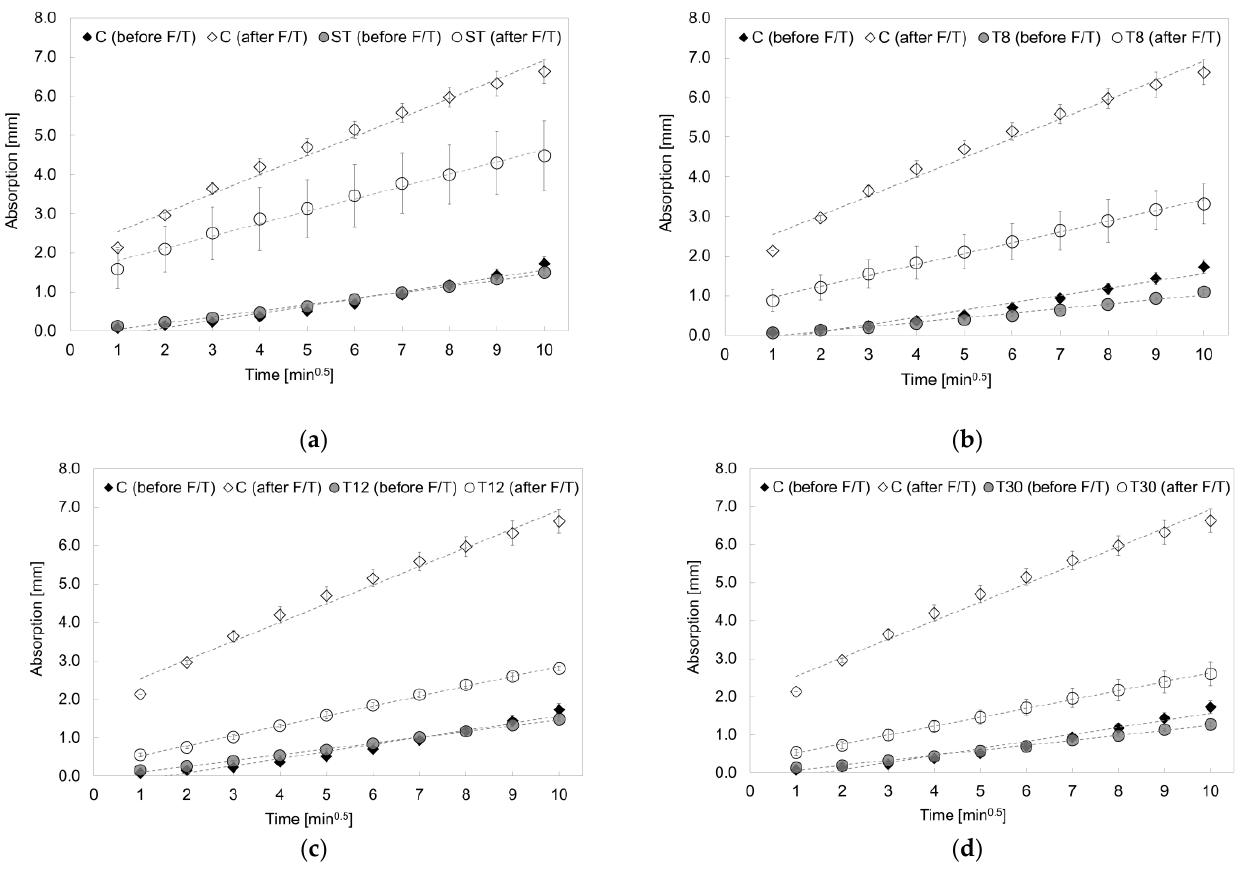
Figure 8. Water absorption rate curves for series ( a ) ST, ( b ) T8, ( c ) T12 and ( d ) T30 before and after freeze/thaw cycles compared to series C. The error bars represent the standard deviation. The dotted lines represent the linear interpolation used to calculate the sorptivity values.